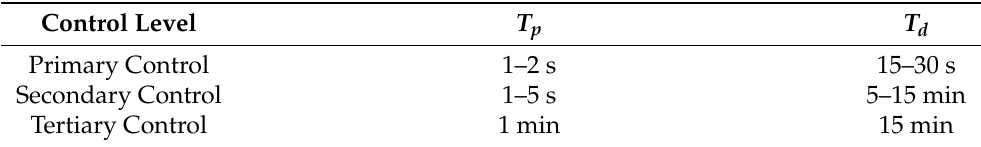
Figure 1. Frequency control in the power system with the MG presence. The power system includes RES and SG-based power plants, Large scale ESSs, RLs, and MGs. Each element supports FR with the portion that is specified by TSO. The MG also includes RES and SG-based power plants, ESSs, critical, and noncritical loads that contribute to the FR in the MG domain. The MG elements are under the supervisory of MGCC. Table 2. LFC time constraint according to ENTSO